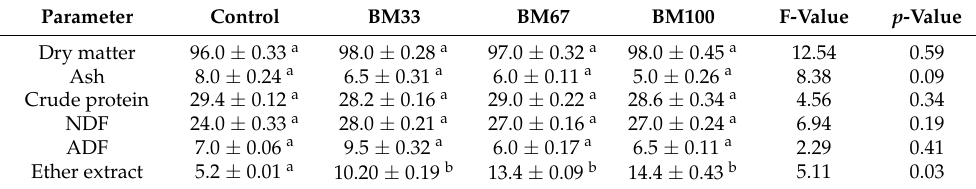
Table 3. Mean ( ± SE) proximate composition of the experiment